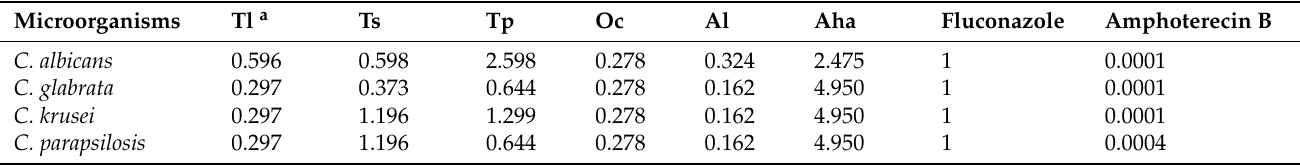
Table 3. Minimal inhibitory concentrations (MIC) of essential oils and two conventional antifungals (mg/mL).